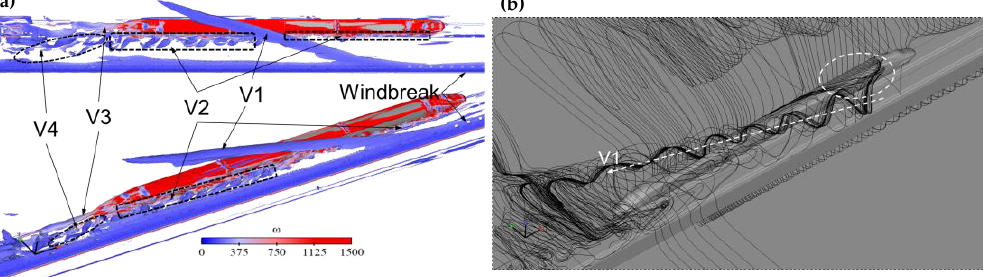
Figure 9. Flow structures around the train at t * = 47: ( a ) vortex distribution ( Q = 5000) and ( b ) space streamlines.